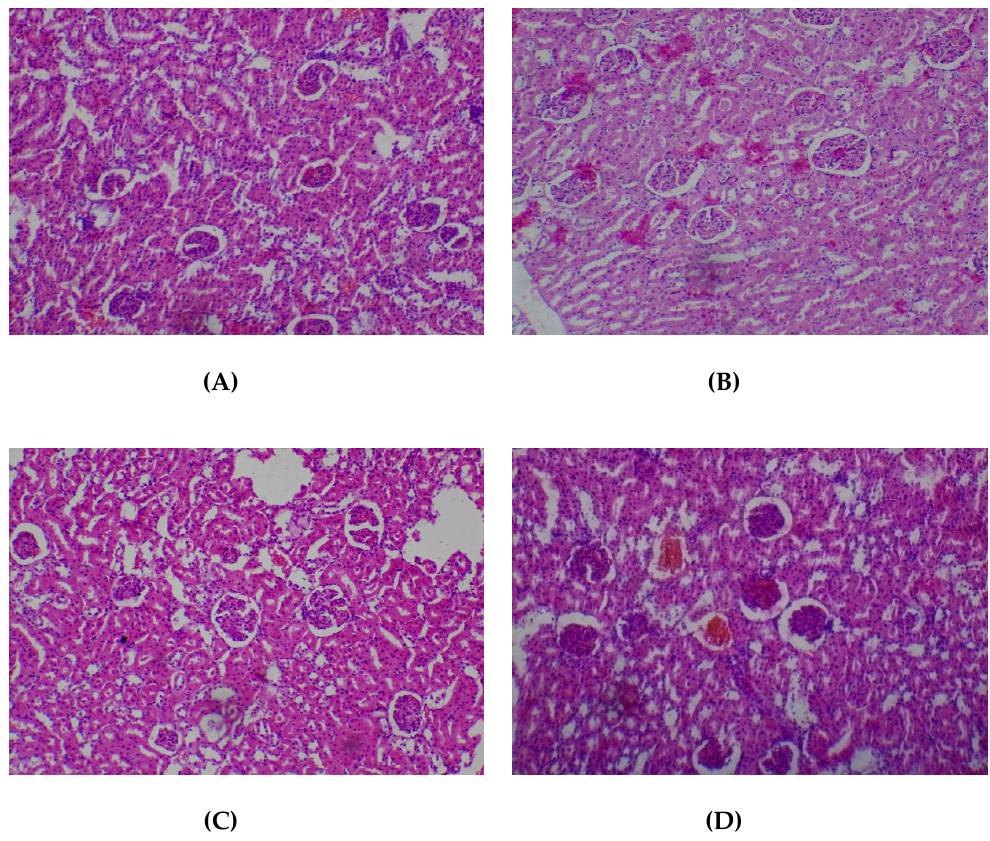
Figure 4. Histopathological presentation of rat kidney. ( A ) represents the control group treated with distilled water (Normal); ( B ) represents the group treated with 80 mg/kg T. occidentalis extract (Normal); ( C ) represents the group treated with 400 mg/kg T. occidentalis extract (Normal) and ( D ) represents the group treated with 2000 mg/kg T. occidentalis extract (Normal) ( × 400). Histologic sections of kidney tissue show normocellular glomerular tufts disposed on a background containing renal tubules. No other abnormalities are seen.